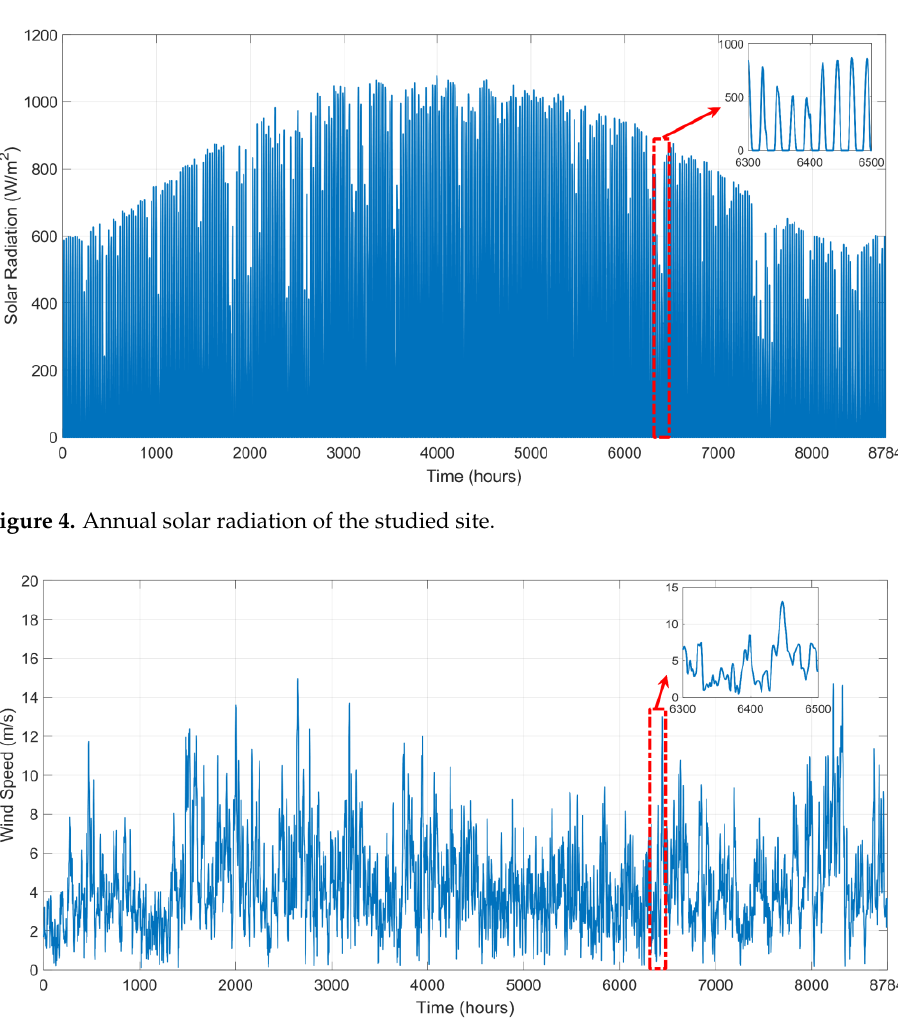
Figure 5. Annual wind speed of the studied site.